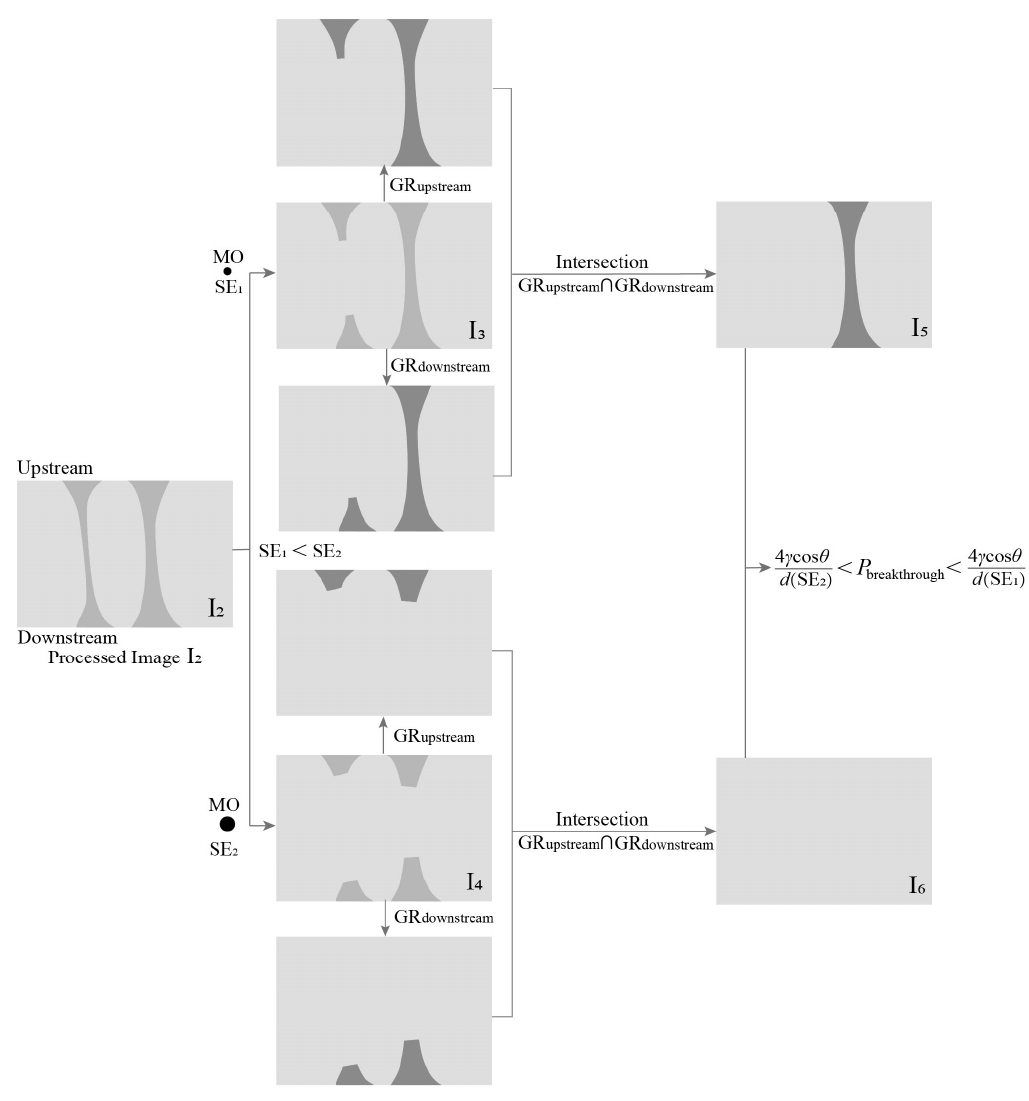
Figure 14. Step 2: determination of the gas breakthrough pressure.